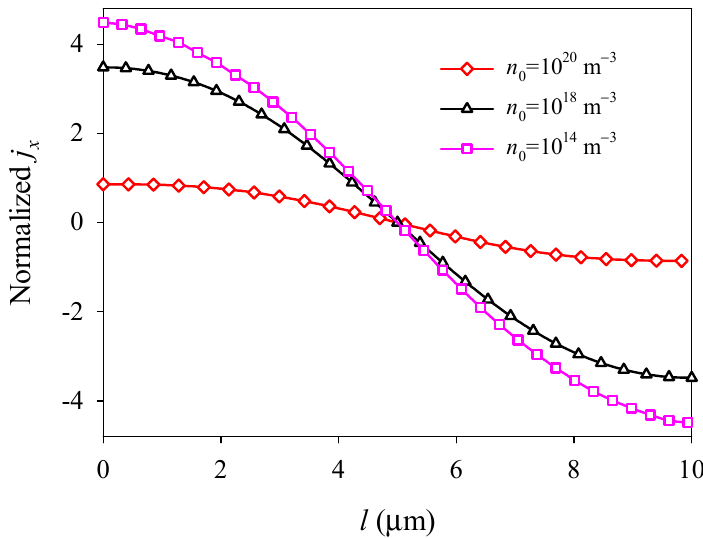
Figure 10. Normalized surface electric current density j x along the midline y = d/ 2 versus initial Figure 8. Normalized electron concentration perturbation ∆ N along the midline y = d /2 versus initial electron concentration n 0 . electron concentration n 0